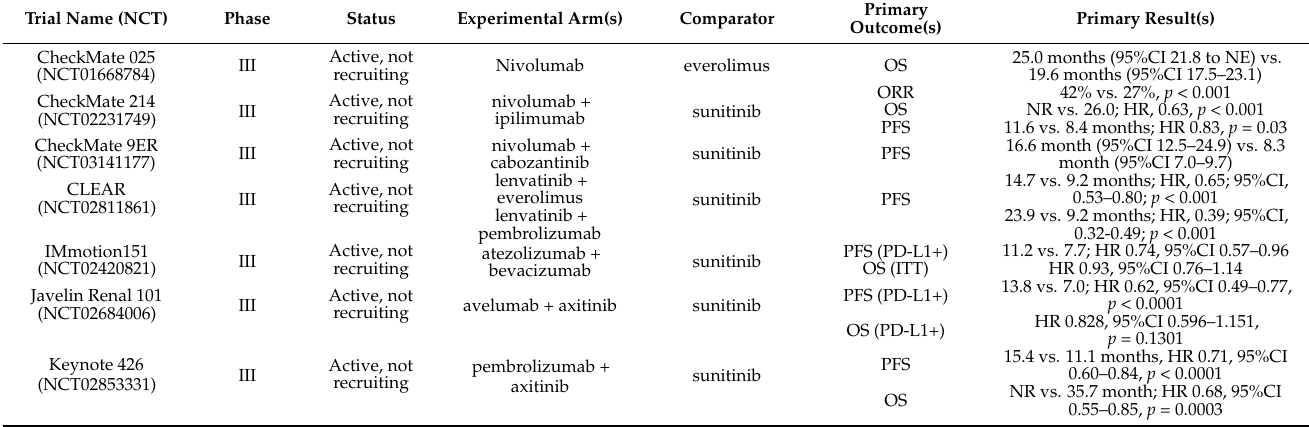
Table 2. Phase III clinical trials reporting data in mRCC treated with ICI + ICI or ICI + TT. OS—overall survival.